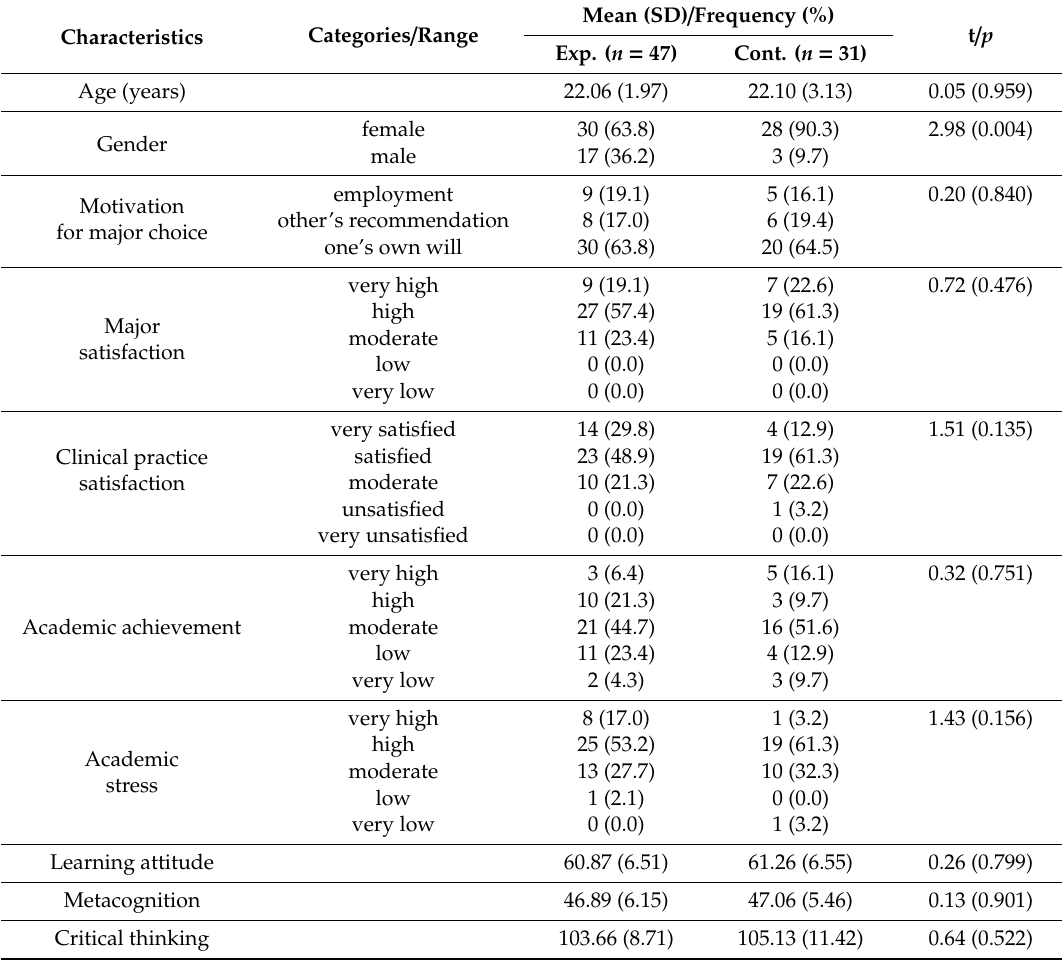
Table 1. General Characteristics.